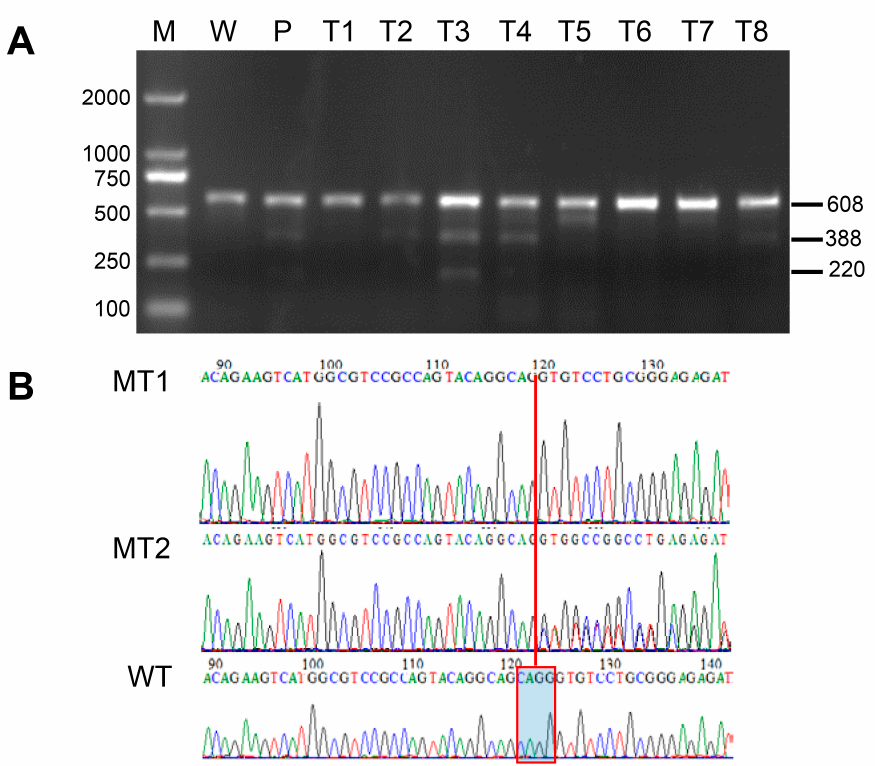
Figure 2. ( A ) A gel document presents the screening of the mutant by the T7E1 method. M, marker; WT, wild type; P, positive control; T1-T8 indicate the sample 1–8. The sizes of the marker and the fragments are indicated in bp beside the document. ( B ) The typical chromatogram of the partial sequence of prmt5 . WT, wild type; MT, mutant. The deletion of the 4 bp in the wild type is highlighted in the red frame.